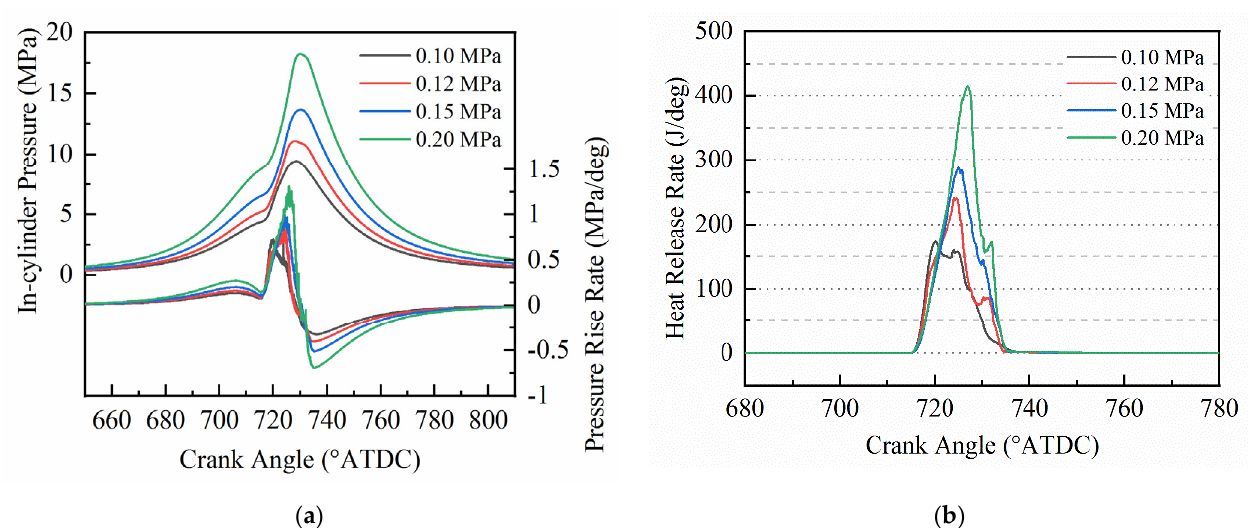
15 of 28 Table 4. Operating parameters of different intake pressures. Parameter